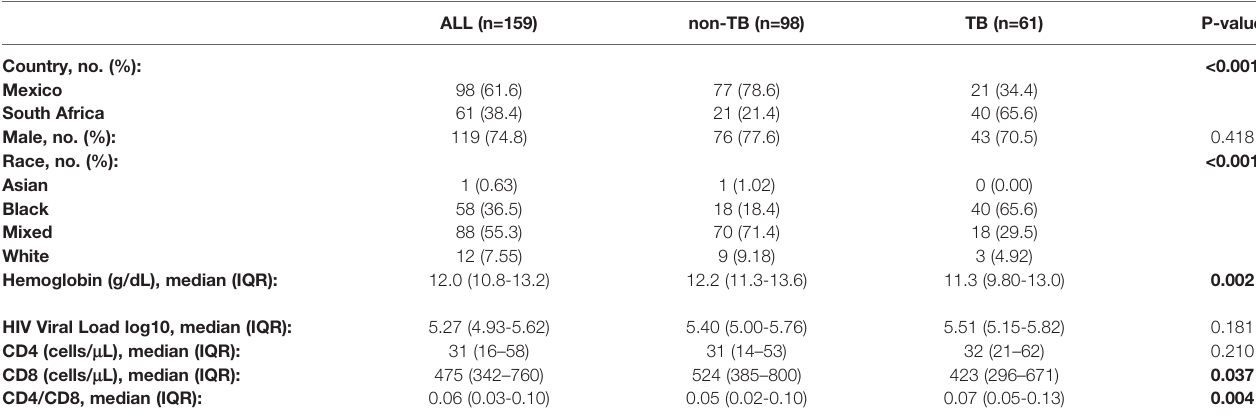
TABLE 1 | Characteristics of the study